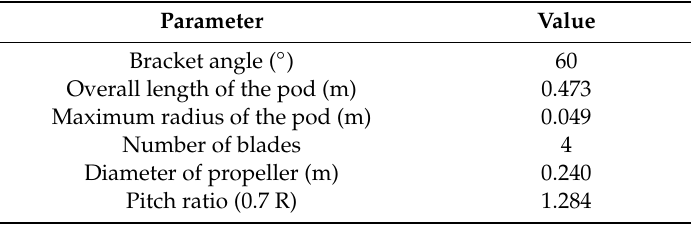
Table 2. Main parameters of the podded propulsor